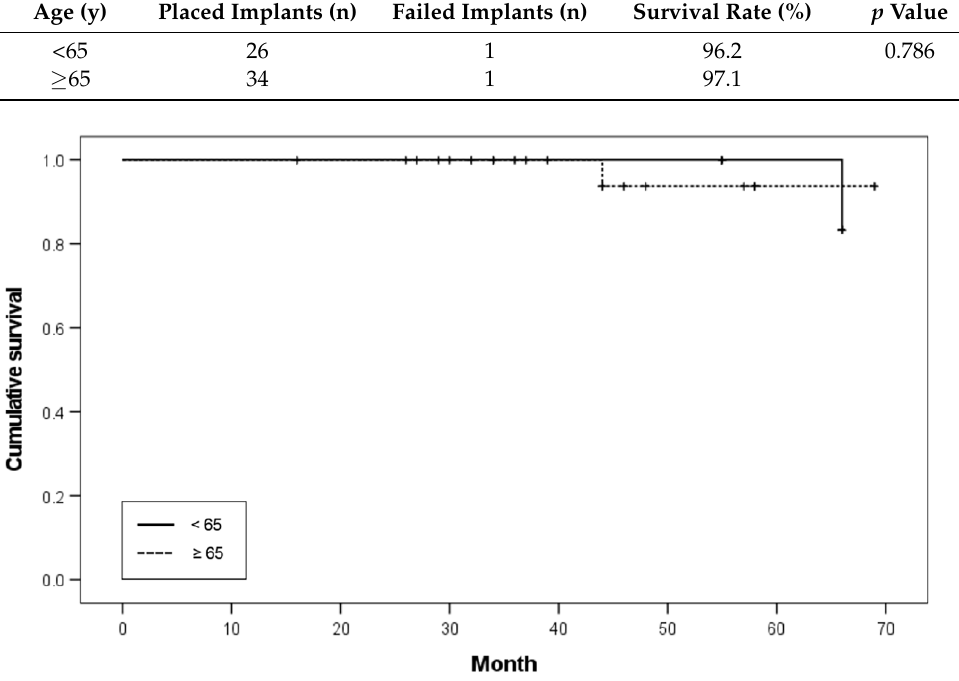
Figure 2. Kaplan-Meier survival curve according to age.